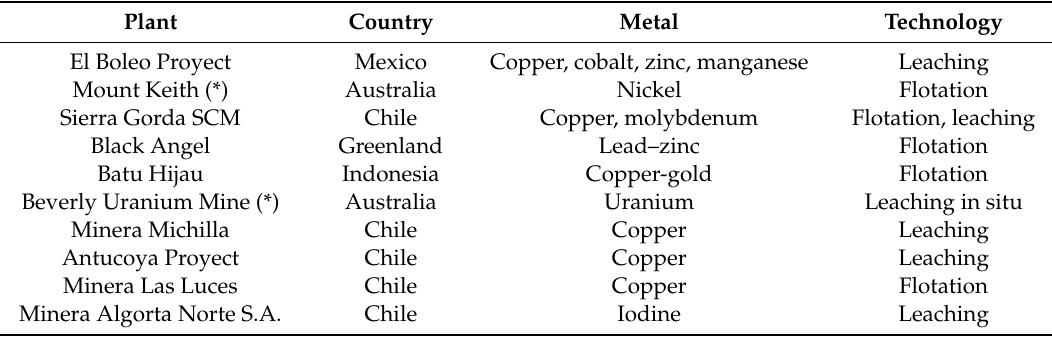
Table 1. Examples of seawater use in mining (adapted from Cisternas and G á lvez [3]). Plant Country Metal Technology El Boleo Proyect Mexico Copper, cobalt, zinc, manganese Leaching Mount Keith (*) Australia Nickel Flotation Sierra Gorda SCM Chile Copper, molybdenum Flotation, leaching Black Angel Greenland Lead–zinc Flotation Batu Hijau Indonesia Copper-gold Flotation Beverly Uranium Mine (*) Australia Uranium Leaching in situ Minera Michilla Chile Copper Leaching Antucoya Proyect Chile Copper Leaching Minera Las Luces Chile Copper Flotation Minera Algorta Norte S.A. Chile Iodine Leaching * Saline